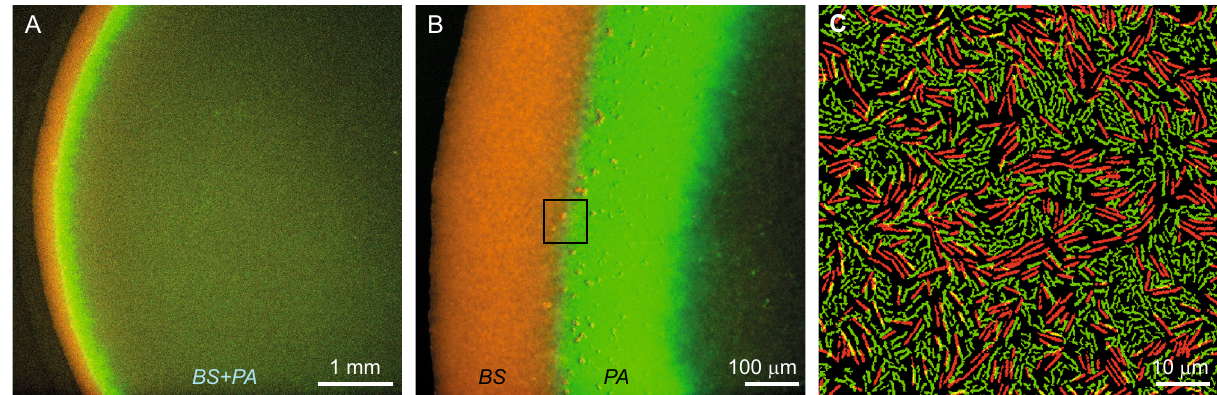
Figure 1. A mixed swarm of WT B. subtilis (red) and WT P. aeruginosa (green)—fluorescence microscopy images. ( A ) Low magnification shows a macroscopic view of the colony. Even though axenic P. aeruginosa grow an order of magnitude slower than axenic B. subtilis colonies, the two species grow together, forming a single, combined colony. ( B ) Larger magnification emphasizes that the two species are macroscopically separated, forming slightly overlapping bands. The boundary between the bands is not sharp. ( C ) A microscopic view of the intermediate region between the bands shows that the species are mixed, but not homogeneously. Local segregation into clusters with a scale of 10–20 µm can be seen. The black square in ( B ) shows the zoom-in region depicted in ( C